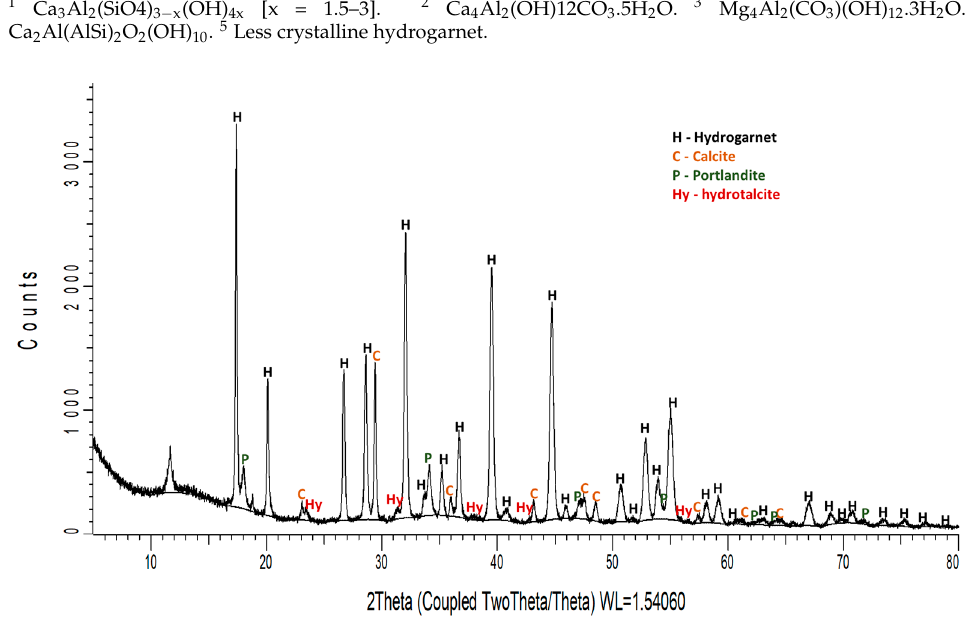
Figure 2. XRD spectrum for test 2 residue.